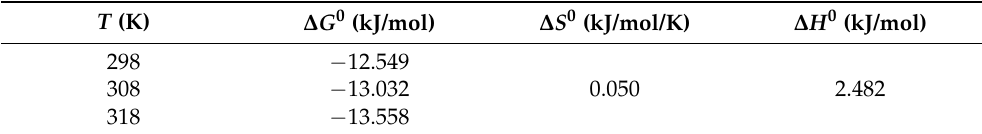
Table 3. Thermodynamic parameters of ammonium adsorption by